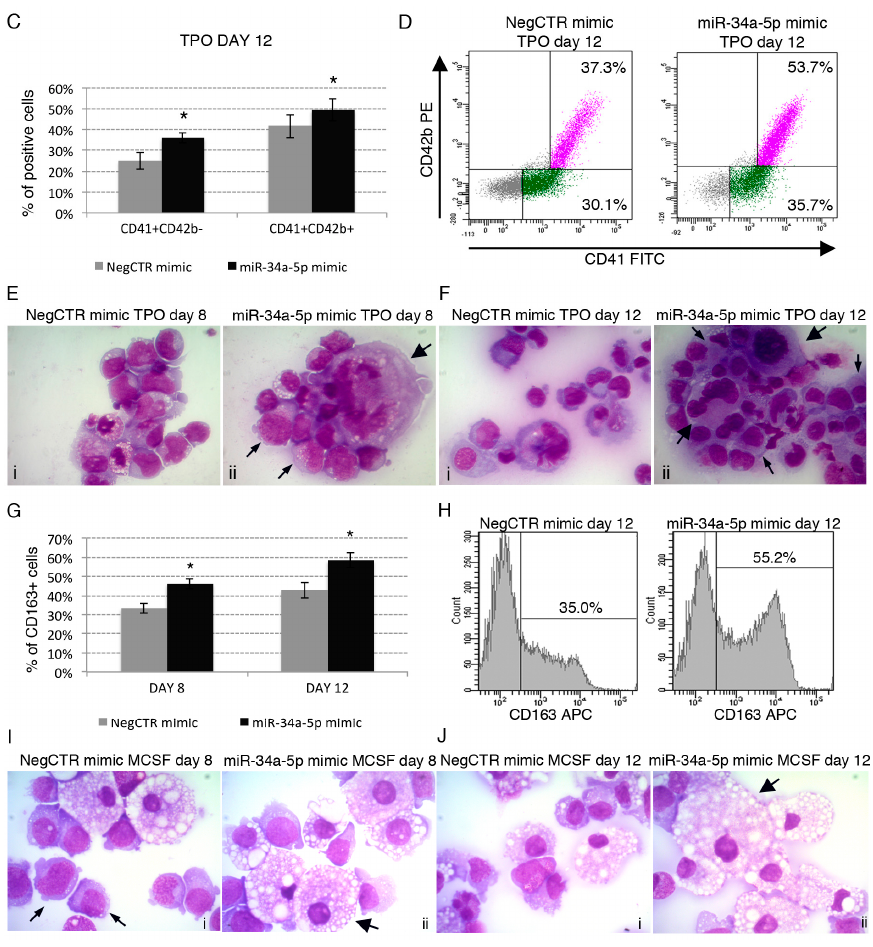
Figure 3. Effects of miR-34a-5p overexpression on megakaryocyte and macrophage differentiation. ( A – C ) Flow cytometric analysis (mean ± SEM; n = 3) of CD41 and CD42b expression at day 4 ( A ); day 8 ( B ) and day 12 ( C ) of TPO-driven megakaryocyte unilineage culture post-nucleofection; ( D ) Representative dot plots for the flow cytometric detection of CD41 and CD42b differentiation markers at day 12 of megakaryocyte unilineage culture post-nucleofection; ( E , F ) Morphological analysis of NegCTR mimic ( i ) and miR-34a-5p mimic-transfected cells ( ii ) after May–Grunwald–Giemsa staining at day 8 ( E ) and day 12 ( F ) of megakaryocyte unilineage culture post-nucleofection in a representative experiment. Thick arrows indicate large megakaryocytes with polyploid nuclei; thin arrows indicate cells with a granular cytoplasm, which is a feature of megakaryocyte maturation. Magnification, ×1000; ( G ) Flow cytometric detection (mean ± SEM; n = 3) of the CD163 marker at day 8 and day 12 of monocyte/macrophage unilineage culture post-nucleofection; ( H ) Representative histograms for the flow cytometric detection of CD163 marker at day 12 of MCSF-driven monocyte/macrophage unilineage culture post-nucleofection; ( I , J ) Morphological analysis of NegCTR mimic ( i ) and miR-34a-5p mimic-transfected cells ( ii ) after May–Grunwald–Giemsa staining at day 8 ( I ) and day 12 ( J ) of monocyte/macrophage unilineage culture post-nucleofection in a representative experiment. Thick arrows indicate macrophages; thin arrows indicate monocytes. Magnification, ×1000. Three independent experiments (indicated by n = 3 ) were performed with different healthy donor-derived cord blood units. * p ≤ 0.05 in miR-34a-5p mimic compared to NegCTR mimic sample. Abbreviations: TPO, thrombopoietin; MCSF, monocyte colony-stimulating factor.